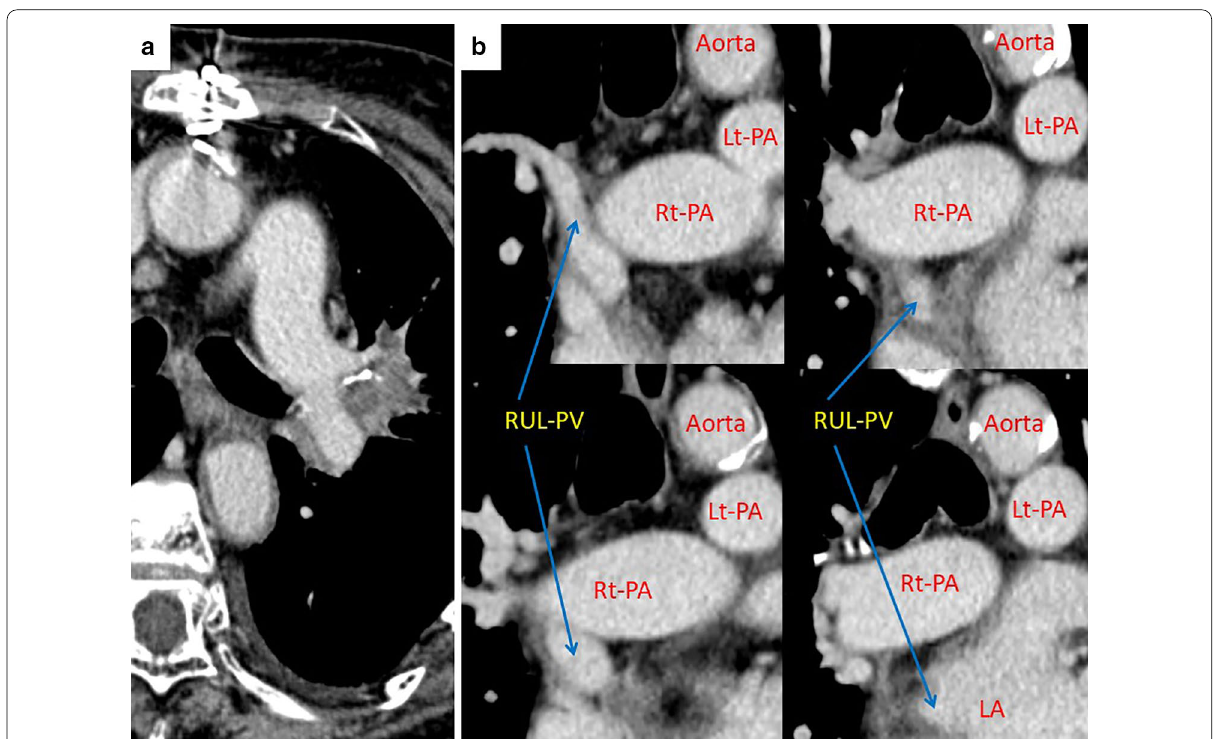
Fig. 3 Enhanced chest computed tomography after induction chemoradiation therapy ( a ) revealed a 3.2-cm solid mass in the left-upper lobe that showed a partial response according to the response evaluation criteria in solid tumor ( 49% in size). The enhanced chest computed tomography − (coronal view) after surgical correction of the partial anomalous pulmonary venous connection in right-upper lobe ( b ) showed the right-upper lobe pulmonary vein draining into the left atrium. RUL right-upper lobe, RML right-middle lobe, PV pulmonary vein, PA pulmonary artery, Rt right, Lt